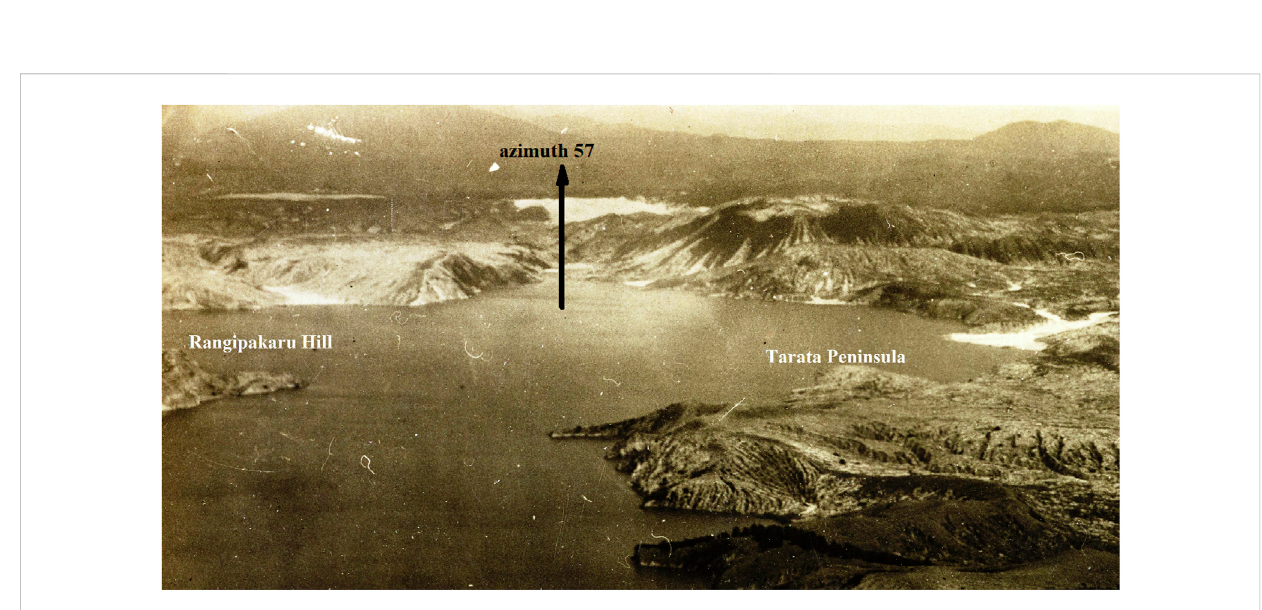
FIGURE 8 LakeRotomahana,RangipakaruHill(nowPatitiIsland),andTarataPeninsulac.1921lookingsouthwest,alongtheriftazimuthat57 ° (Cotton,1921;Te